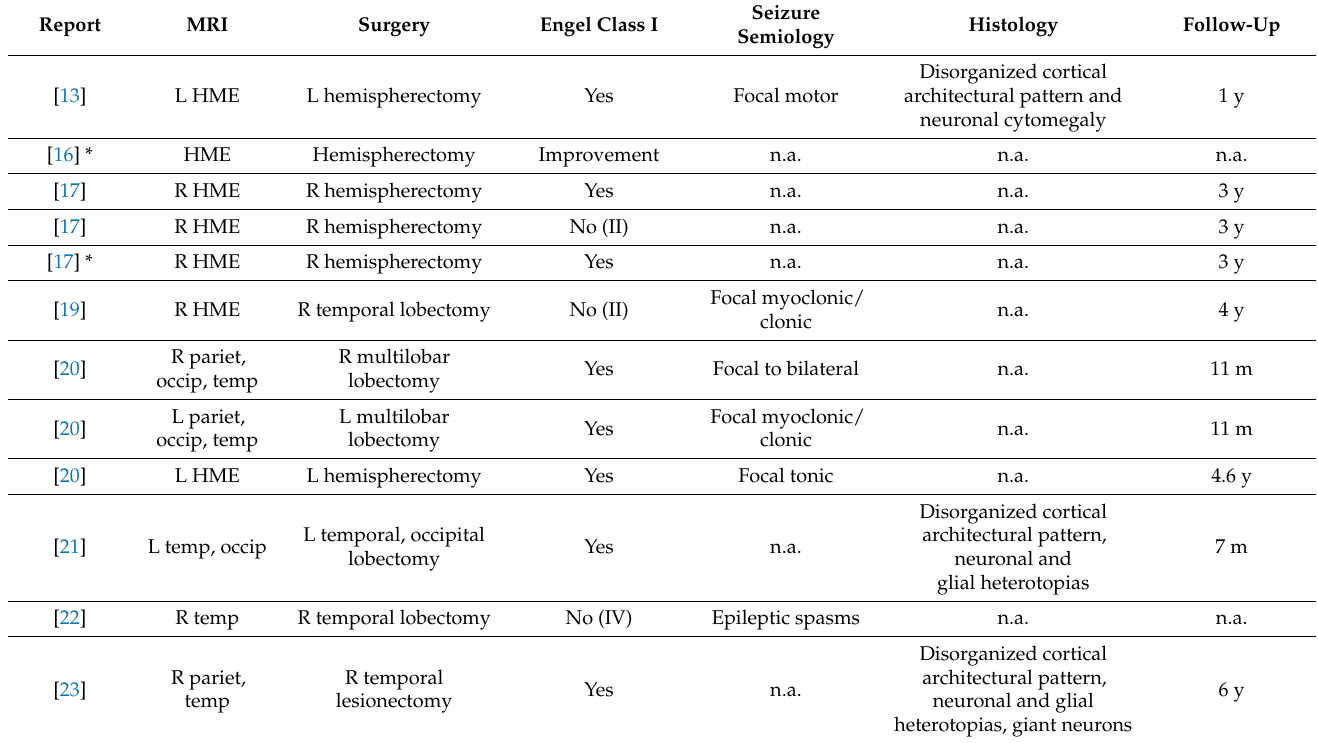
Table 1. Summary of relevant clinical, imaging, and histological data from individual cases in previously published reports.